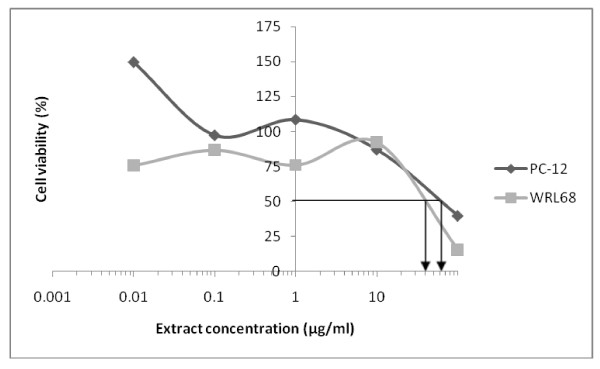
Cytotoxic effects of HAB16R13 against PC-12 and WRL68 cell lines. Each point is expressed as the mean of three independent experiments.